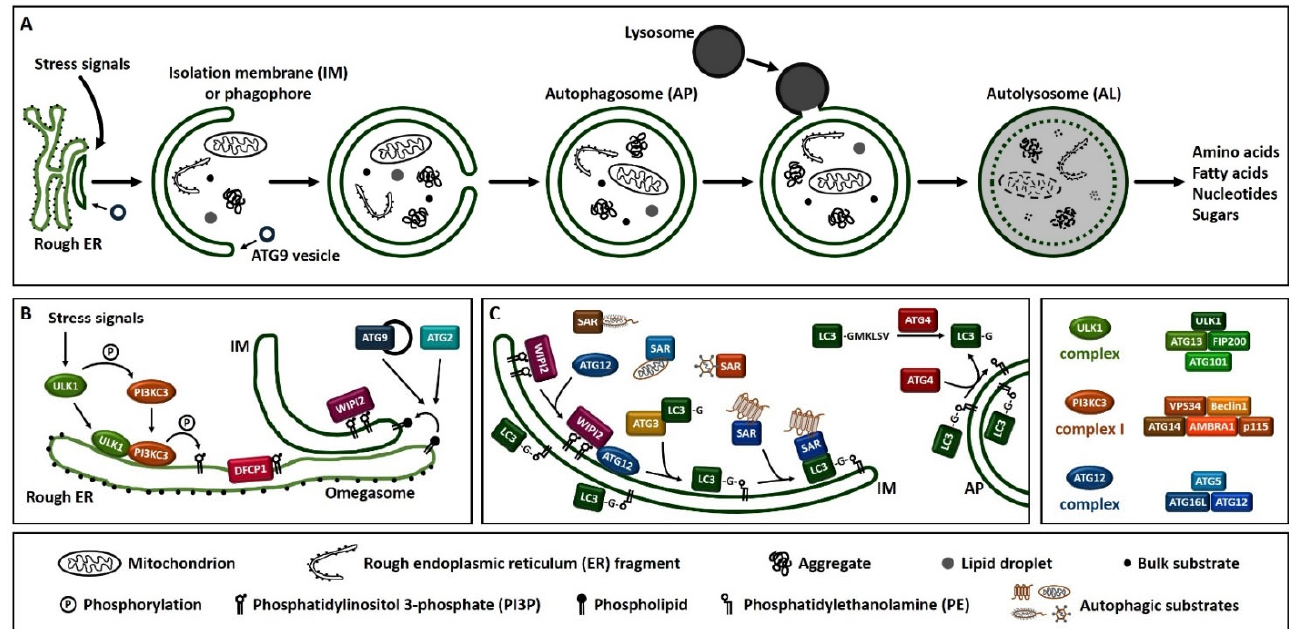
Figure 1. Overview of the autophagy process in human. ( A ). Schematic representation of autophagosome formation and cargo degradation. Complete autophagosomes may fuse with endosomes to form amphisomes, which further fuse with lysosomes. ( B ). Omegasome and isolation membrane generation. ( C ). Isolation membrane expansion, LC3 processing and autophagic substrate sequestration. Additional membrane sources may contribute to isolation membrane formation and expansion. SAR: selective autophagy receptor, LC3 ‐ GKLSV: pro ‐ LC3, LC3 ‐ G: LC3 ‐ I, LC3 ‐ G ‐ PE: LC3 ‐ II.